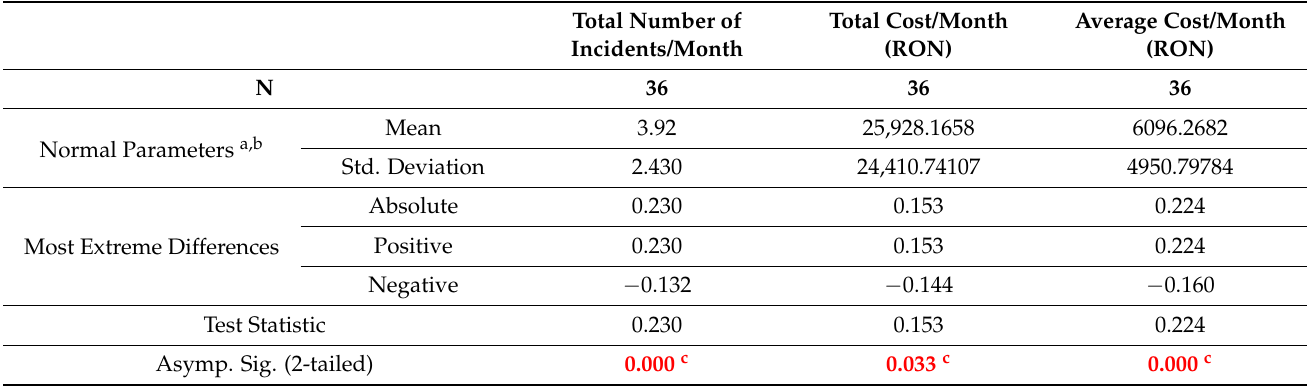
Table 4. Results for normal distribution test with One-Sample Kolmogorov–Smirnov